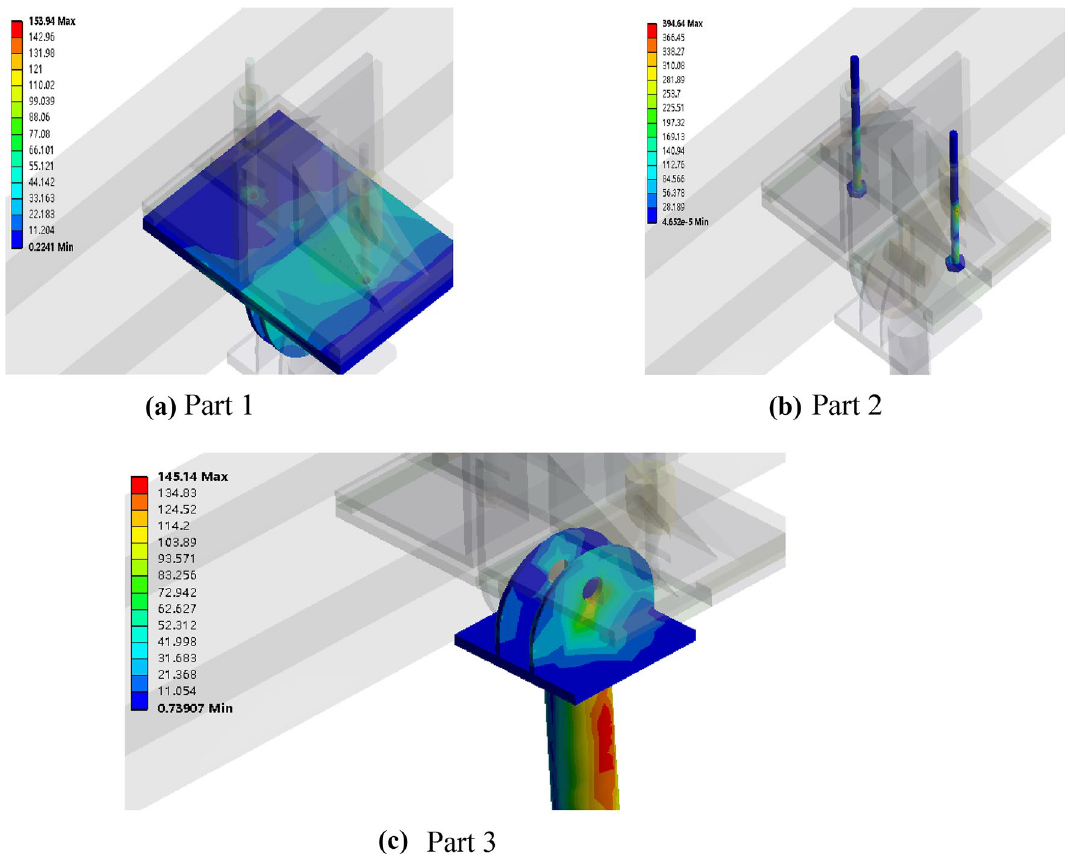
Fig. 12 Equivalent stress nephogram of each part of strut joint